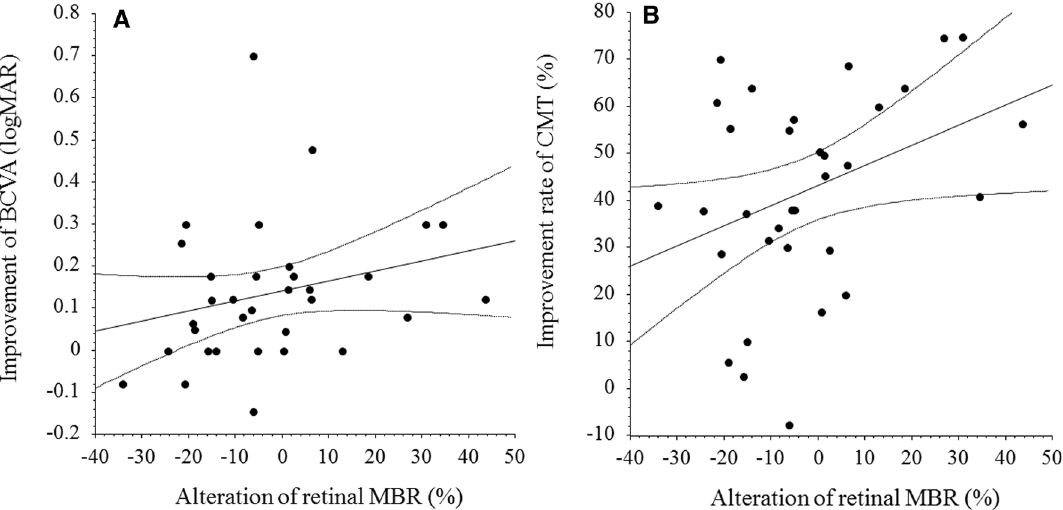
Figure 2. Correlation between change in retinal MBR and improvement of BCVA and CMT after IRI. ( A ) There was no significant correlation between change in retinal MBR and improvement of BCVA 1 month after IRI therapy (ρ = 0.26, P = 0.149). ( B ) A significant correlation was noted between change in retinal MBR and improvement of CMT at 1 month (ρ = 0.36, P = 0.039). BCVA, best corrected visual acuity; MBR, mean blur rate; IRI, intravitreal ranibizumab injection.